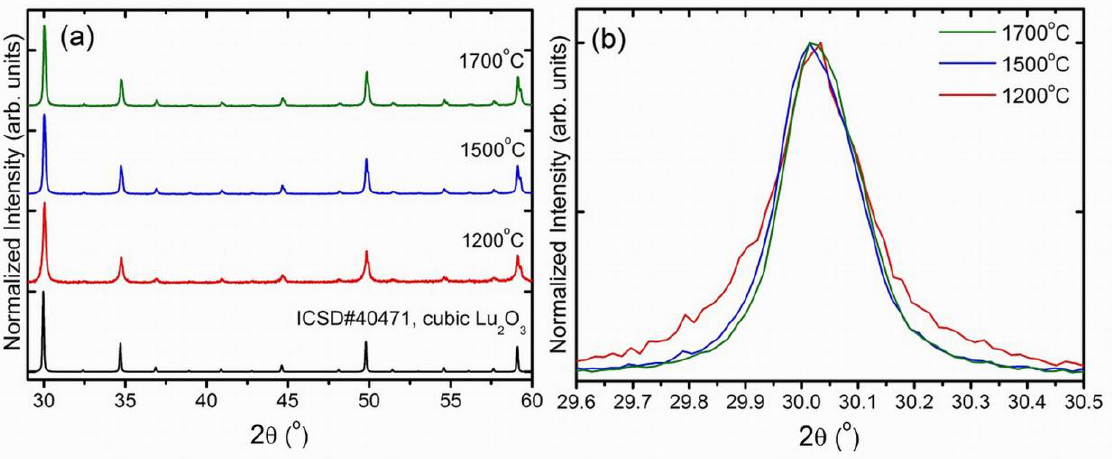
Figure 6. ( a ) XRD patterns of Lu O :0.05%Pr,0.1%Hf ceramics annealed in mixture of 2 3 25%H + 75%N for 5 h at different sintering temperatures: 1200  C, 1500  C and 2 2 1700  C in the range of 29–60 degree; ( b ) Broadening of the line around 29.6–30.5 degree proves that after heating at 1200 °C the crystallites are noticeably